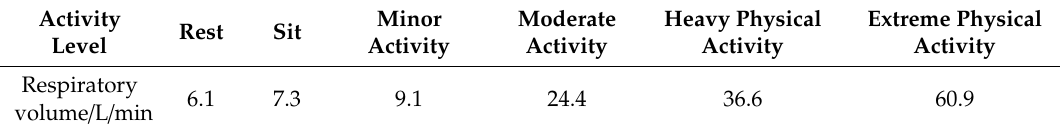
Table 4. Short-term respiration of humans.